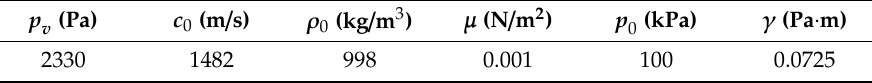
Table 4. Simulation conditions for single bubble